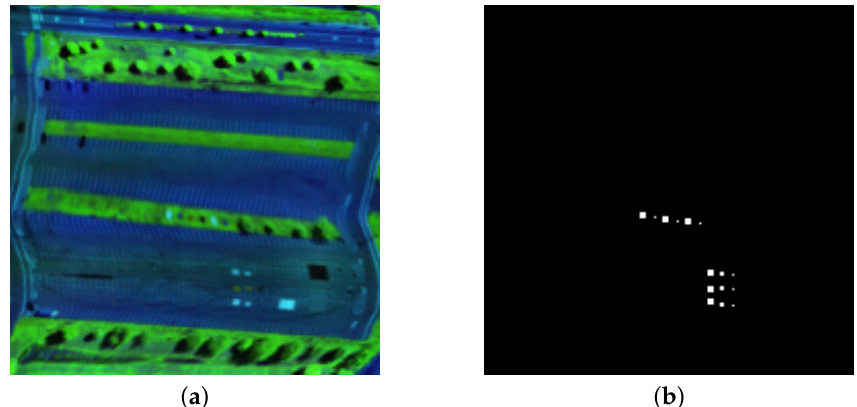
Figure 6. Illustration of the SpecTIR dataset: ( a ) false color (RGB: 60, 30, 20); ( b ) the ground-truth map.